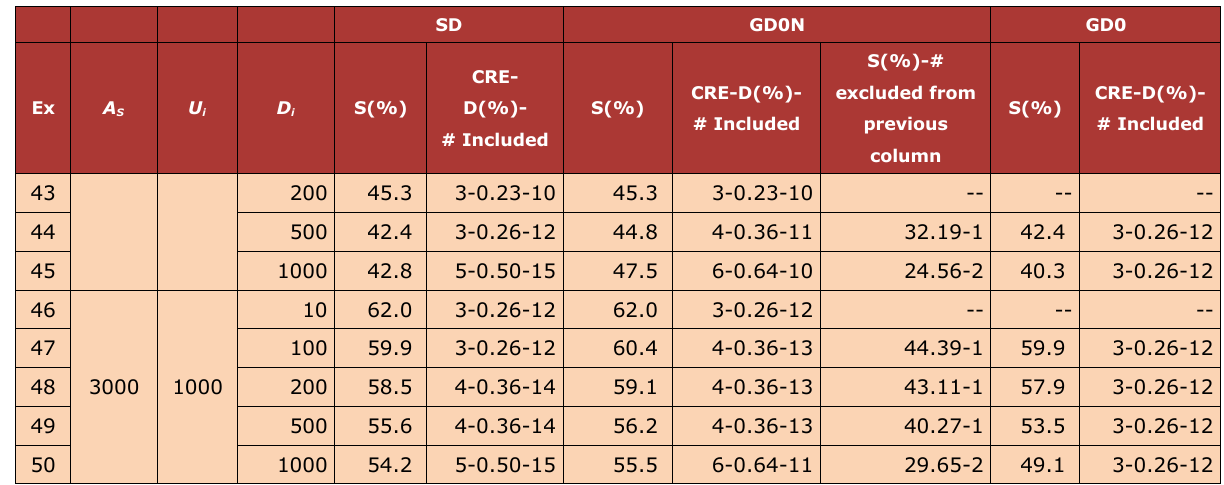
Table 2. Numerical examples with single CRE